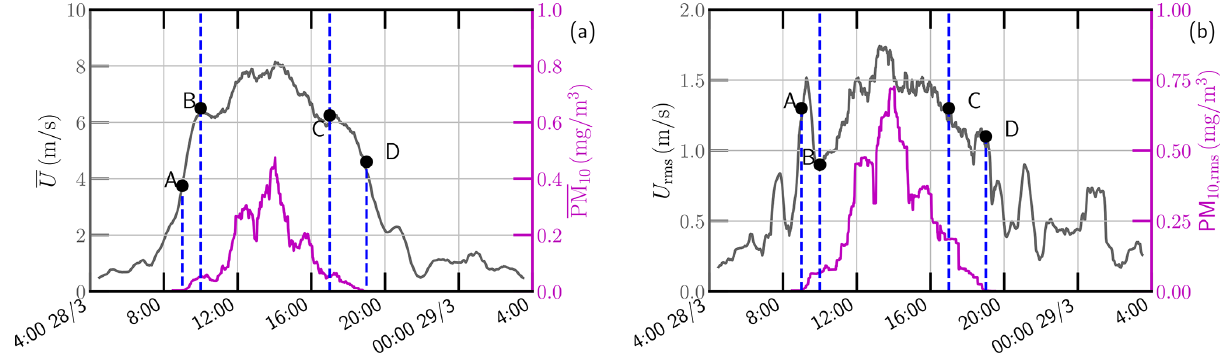
Figure 4. (a) Hourly averaged wind speed U and PM 10 at a height of 3.49m. (b) The corresponding root-mean-square value. This SDS event is roughly divided into three stages, which are illustrated by A–D; see the main text for more detail.